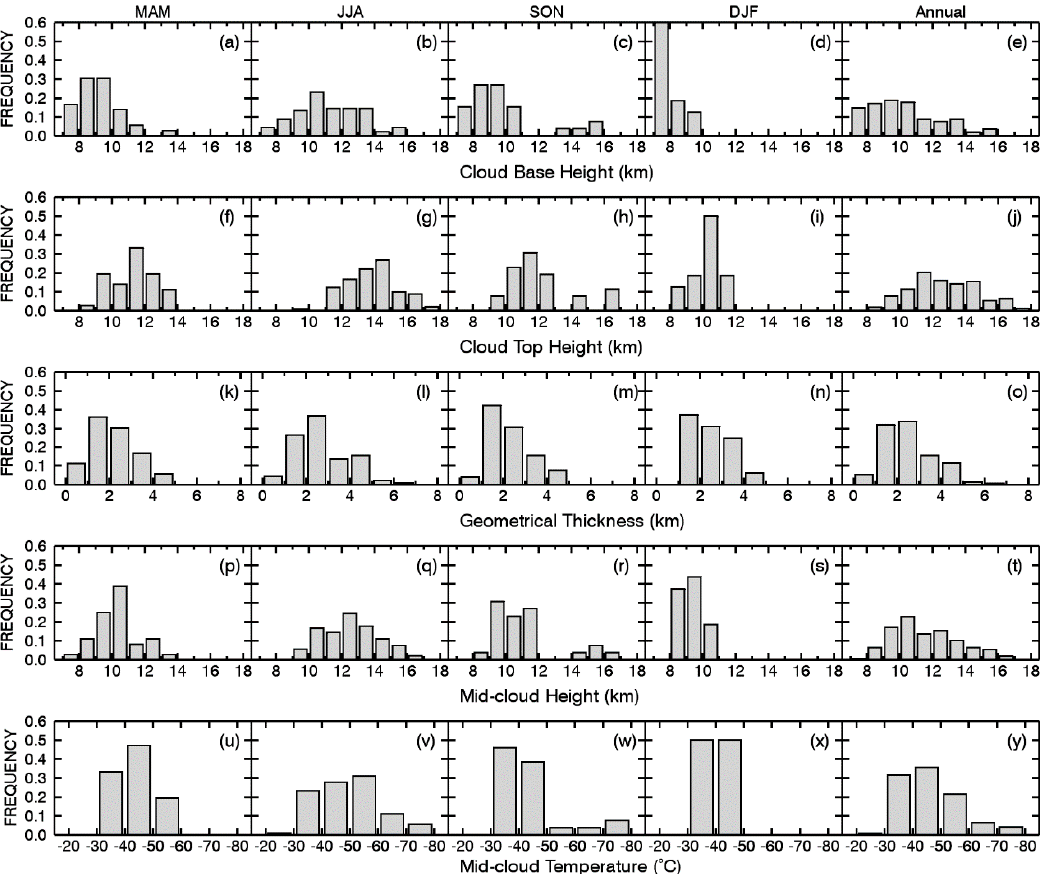
Figure 4. Normalized histograms of cloud base ( a – e ) and top ( f – j ) heights, geometrical thickness ( k – o ), mid-cloud height ( p – t ), and mid-cloud temperature ( u – y ) in terms of seasonal and annual statistics. Note that the cirrus clouds arise in a broad height range (9–17 km for mid-cloud height) in summer, while they lie in a narrow height region (8–11 km) in winter. Table 1. Mean values and standard deviations (in parentheses) of cirrus geometrical properties and corresponding temperatures from seasonal and annual statistics.